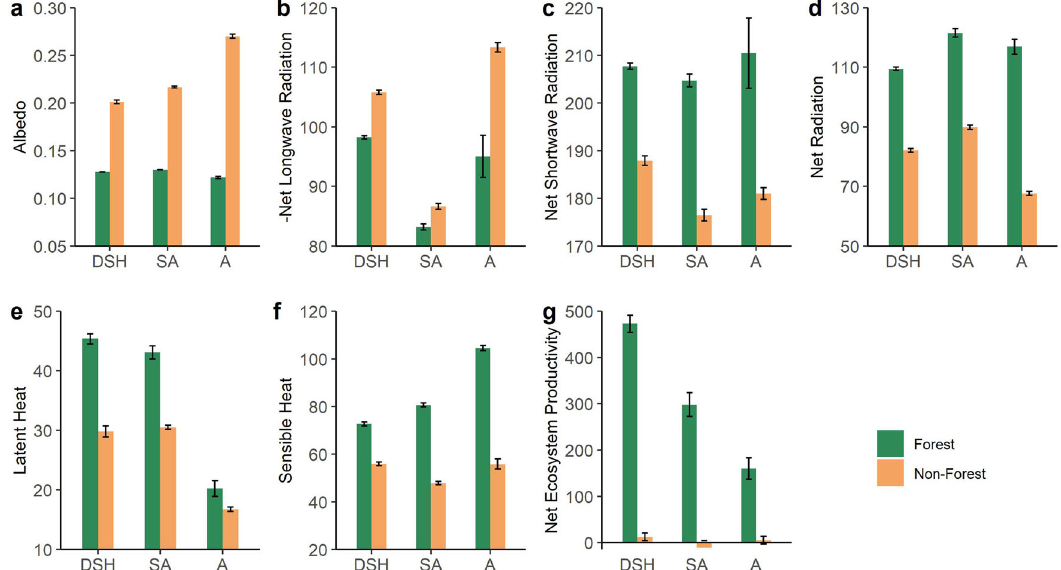
Fig. 2 Forestation effects on the annual mean (2000 – 2015) values of the radiative budget components and net ecosystem production. Annual mean of Albedo ( a ), Net Shortwave Radiation (SWnet in W m − 2 ; b ), − Net Longwave Radiation ( − LWnet in W m − 2 ; c ), Net Radiation (Rn in W m − 2 ; d ), Latent heat fl ux (LE in W m − 2 ; e ), Sensible heat fl ux (H in W m − 2 ; f ), and an annual sum of Net Ecosystem Productivity (NEP in gC m − 2 yr − 1 ; g ). Values are from the forest (green bars) and non-forest (orange bars) ecosystems, across a climatic gradient, with dry-subhumid (DSH) to semi-arid (SA) and arid (A) climatic conditions. Note, the scaling differences among the sub- fi gures. The paired t -test was used to compare multi-annual averages of all variables between forested and adjacent non-forested sites and between sites across the climatic gradient. The error bars are for ± standard errors of the means.